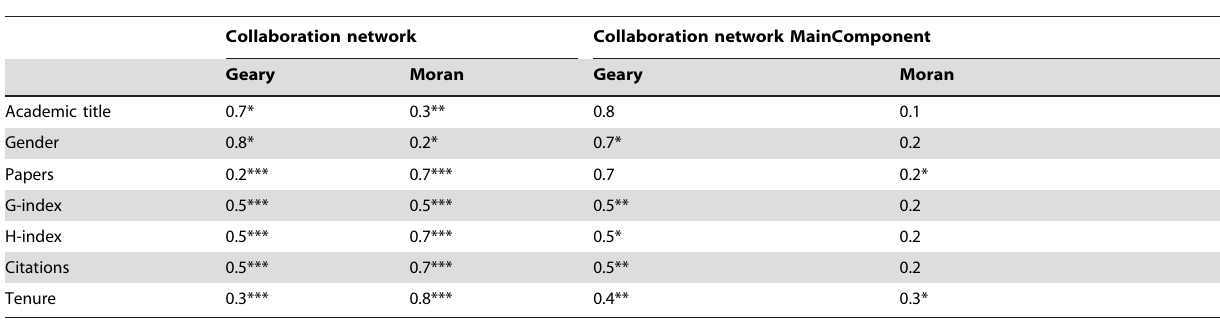
Table 3. Several tests for assessing patterns within the collaboration network and its main